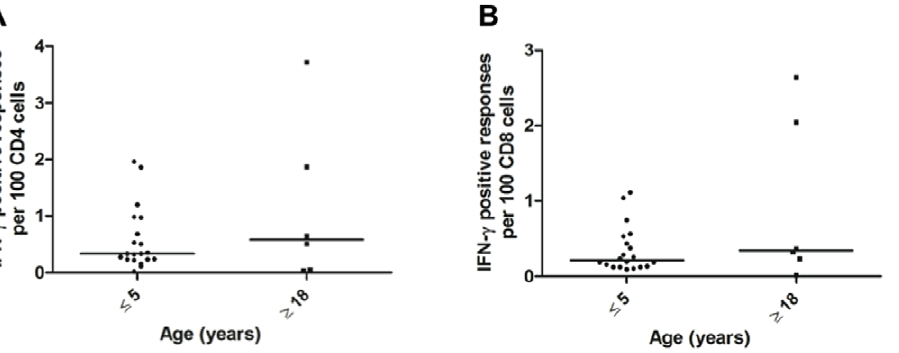
Figure 5. MSP1-specific IFN- c responses generated from both CD + 4 and CD8 + T cells. IFN- c responses to MSP1 42 (3D7 strain) were determined ex vivo by intracellular staining and flow cytometric analysis of cell surface marker expression. The frequency of IFN- c positive responses per 100 CD4 + T cells ( A ) and CD8 + T cells ( B ) after ex vivo rMSP1 42 stimulation were compared between children ( # 5 years) and adults ( $ 18 years). There were no significant differences in the median number of IFN- c responses generated by either CD4 + or CD8 + T cells by age